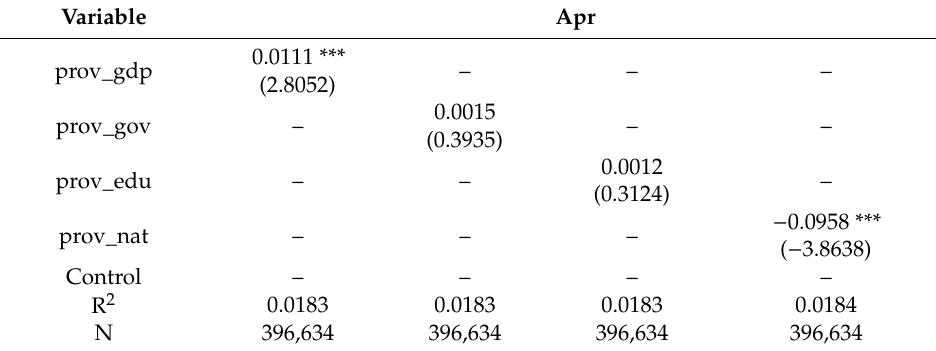
Table 7. Empirical analysis of the causes of regional discrimination (perspective of